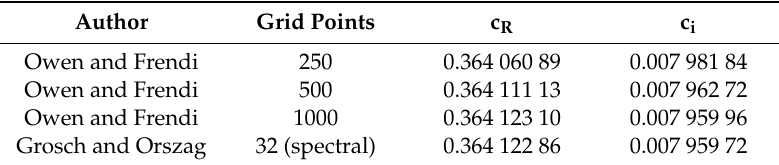
Table 2. Eigenvalues for Blasius flow at di ff erent Reynolds numbers and α = 0.179. Table 1. Eigenvalues for Blasius flow at R = 580 and 𝛼 = 0.179.